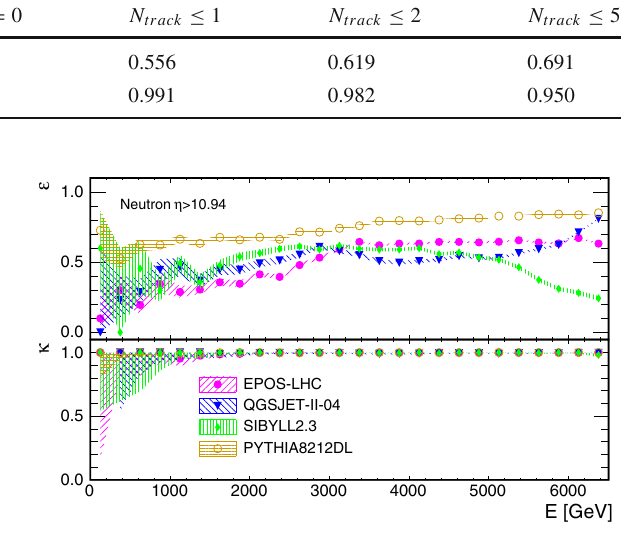
Fig. 8 Efficiency ( top ) and purity ( bottom ) of diffraction selection for the VF ( η > 10 . 94) neutron spectra obtained by using the central-veto technique